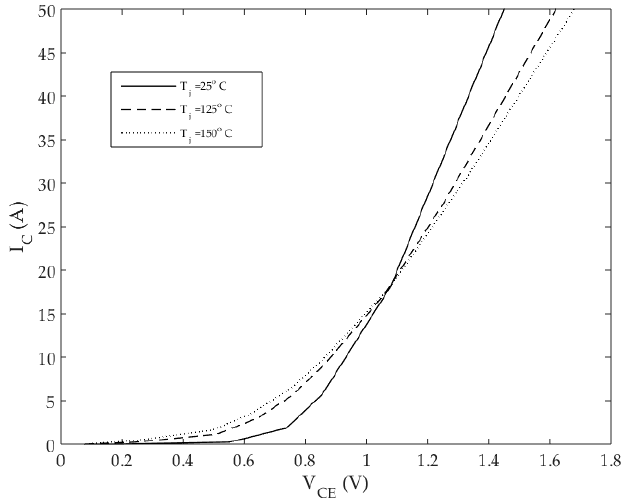
Figure 2. Infineon IGBT V–I curves for power module (Part number: FP50R06KE3) under different junction temperatures [30].